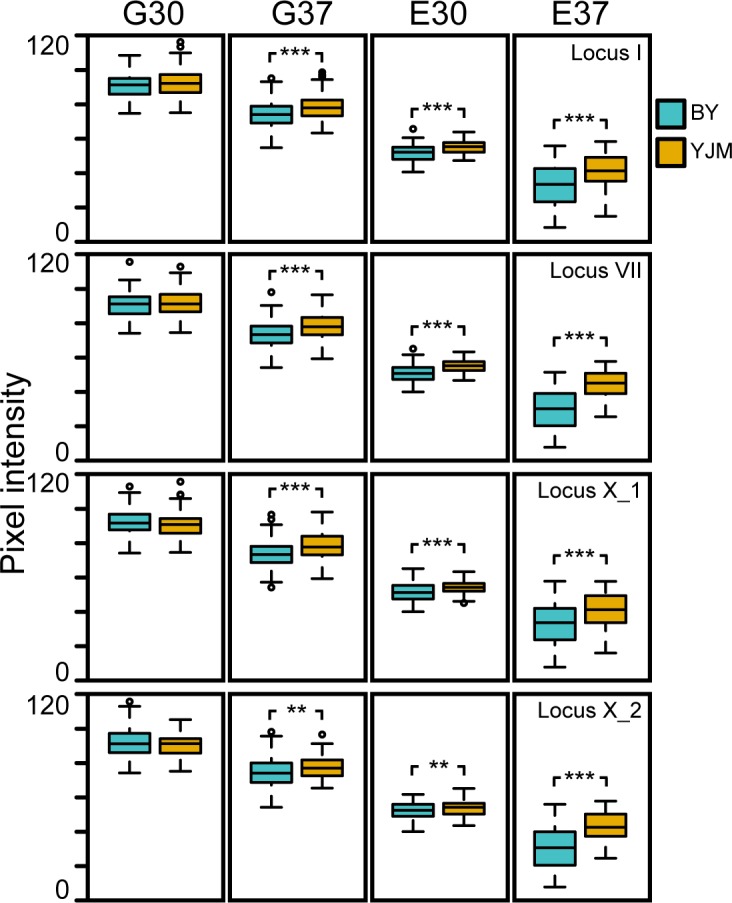
Phenotypic effects of the Chromosome I, VII, X_1, X_2, and XVI loci in the four conditions.Box plots showing the phenotypic effects of the four loci among the F2B7s in each condition. Individuals carrying the BY and YJM alleles at each locus are shown in blue and orange, respectively. Statistical significance was assessed using factor effect tests obtained from the full factorial ANOVAs described in the main text. All four loci were found to have statistically significant phenotypic effect on growth in G37, E30, and E37. ** and *** denote p ≤ 0.01 and p ≤ 0.001, respectively.